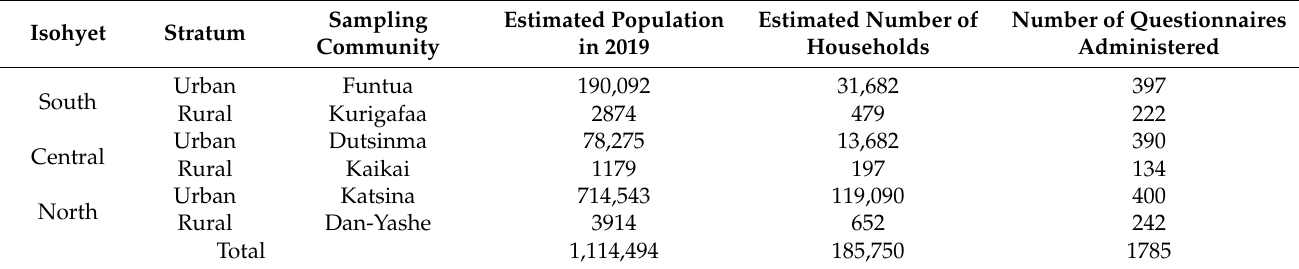
Table 1. Format of questionnaire